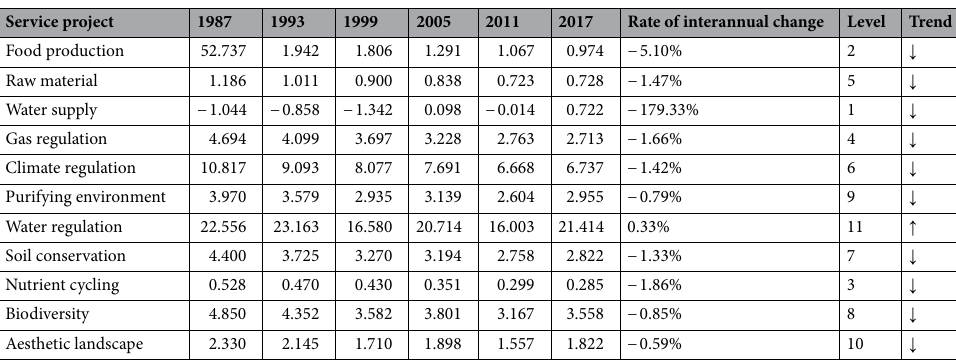
Table 5. Estimated values for different ecosystem functions (ESV f) between 1987 and 2017.